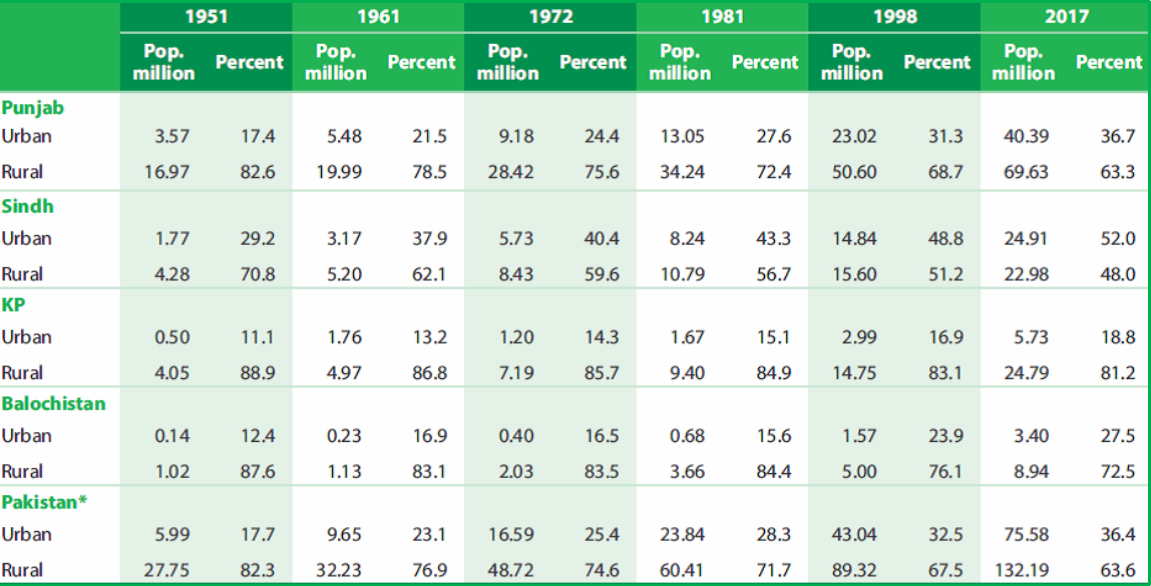
Figure 2. Population and its percentage distribution by urban rural